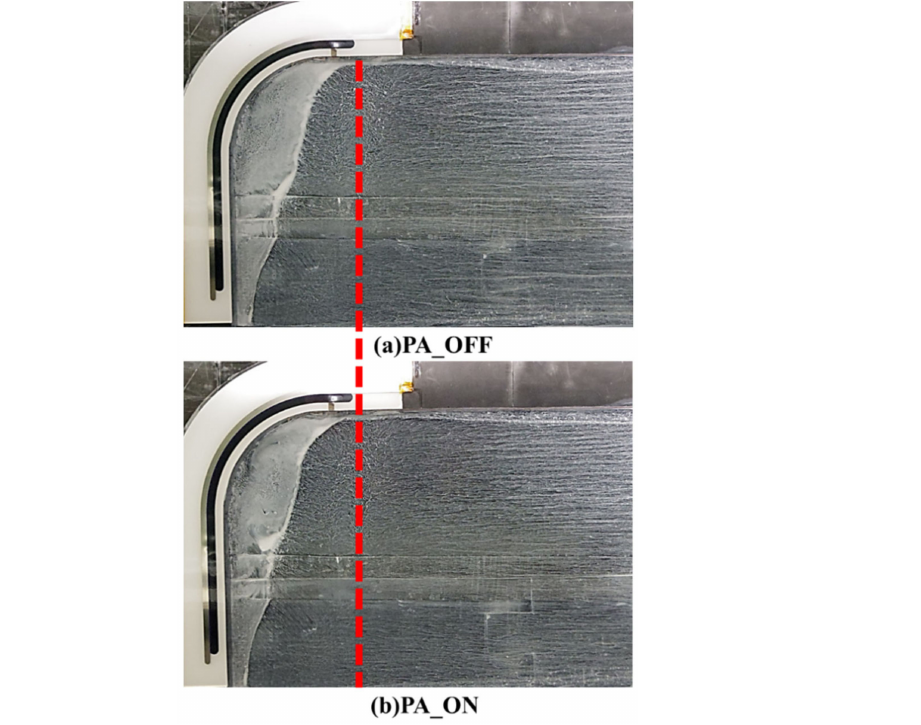
Figure 16. Oil flow visualization result.